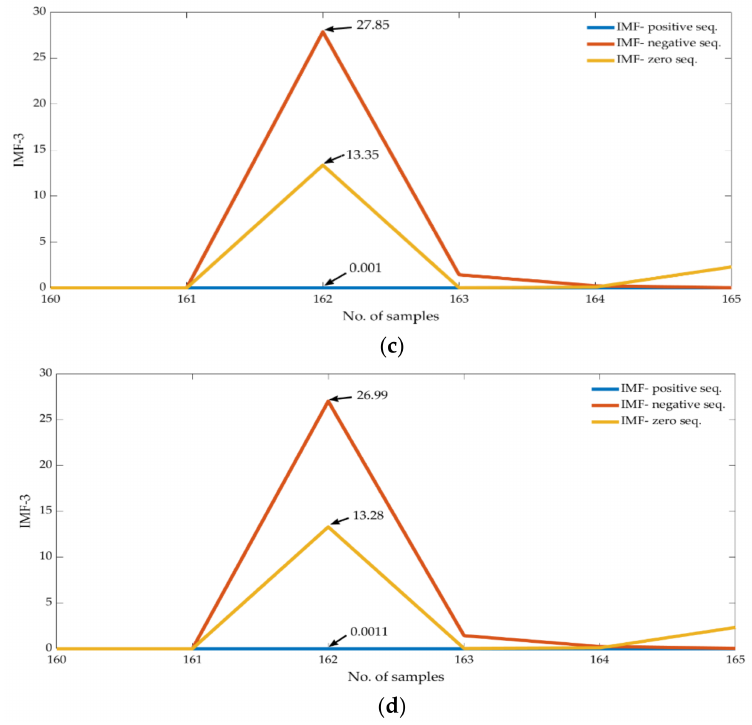
Figure 5. IMF mode-3 extracted by VMD technique in double-line to the ground on phases AB in ISM ( a ) LIF; ( b ) LIF with the SNOP; ( c ) HIF; ( d ) HIF with the SNOP.